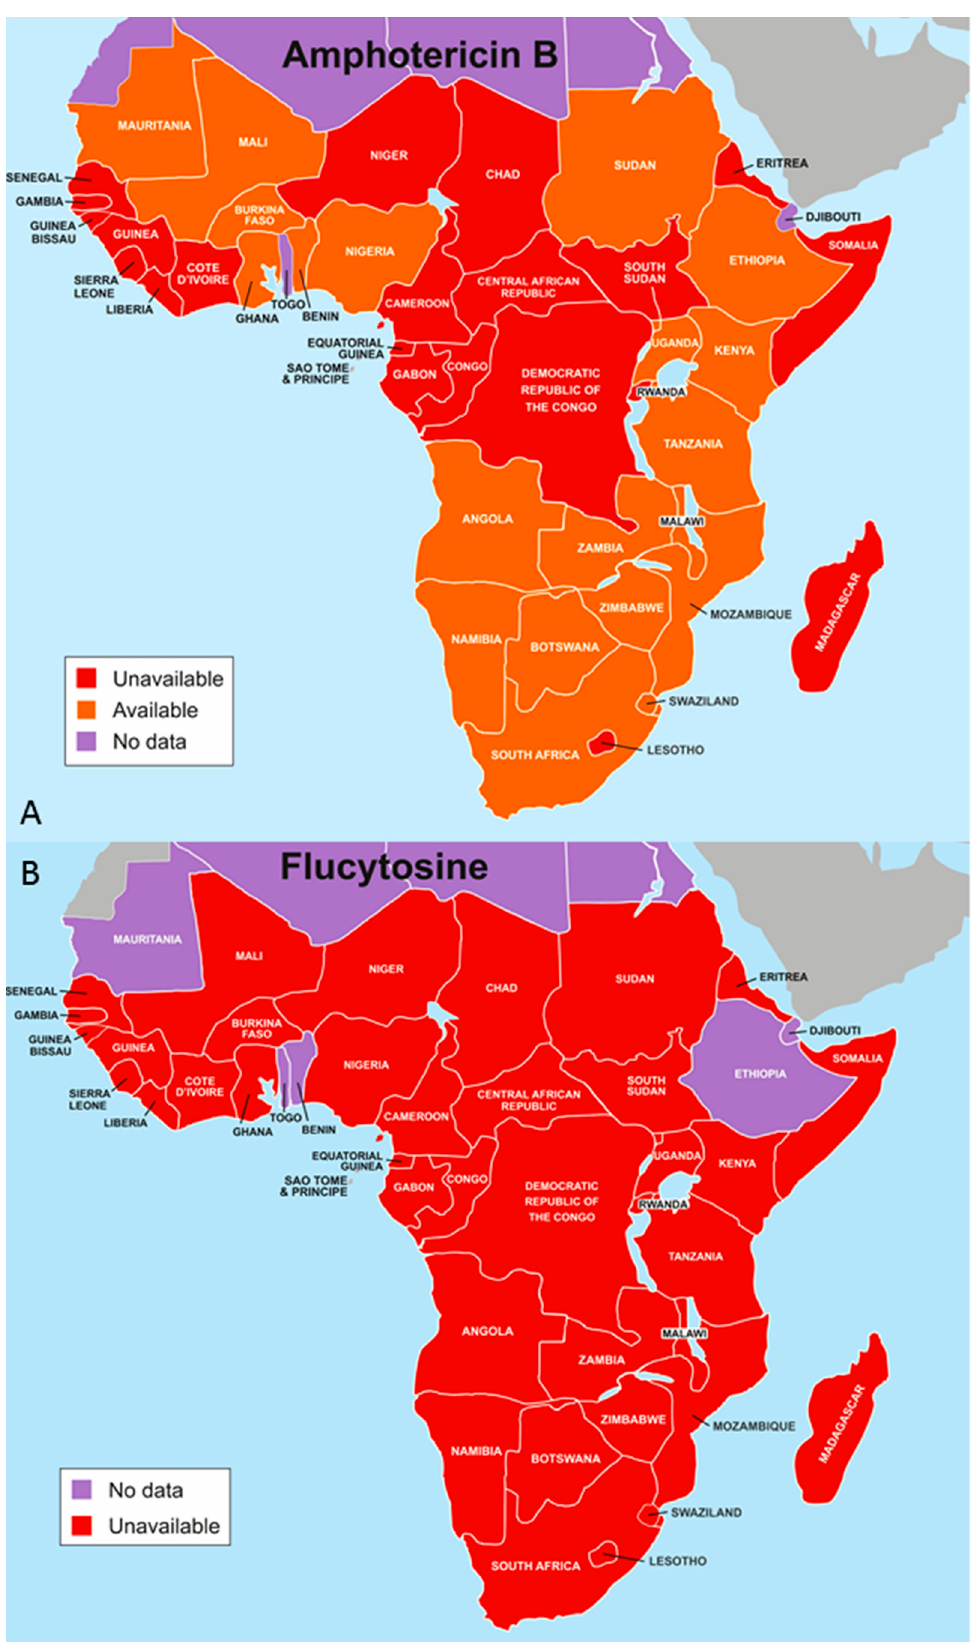
Figure 1. ( A ) Availability of amphotericin B in sub-Saharan Africa; ( B ) Lack of availability of flucytosine in sub-Saharan Africa (maps courtesy of Global Action Fund for Fungal Infections, GAFFI).